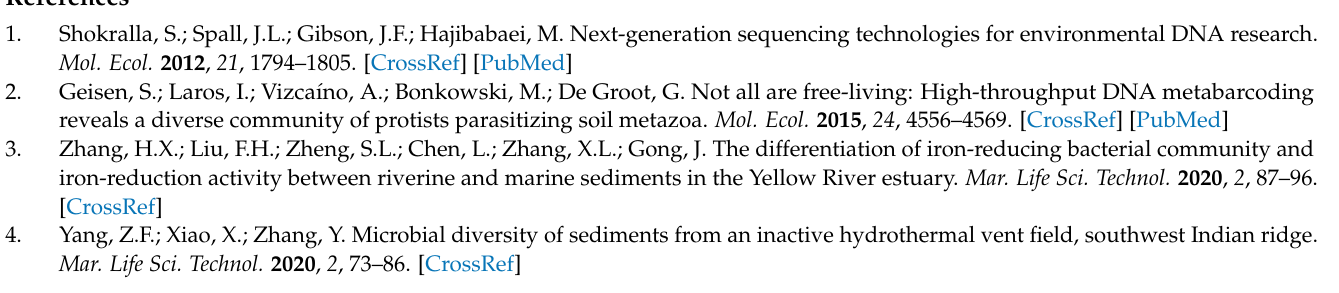
Table S1. Comparison of shared and unique OTUs and their abundance in prokaryotes among three DNA extraction kits; Table S2. Numbers in bold indicate taxa are differentially abundant between